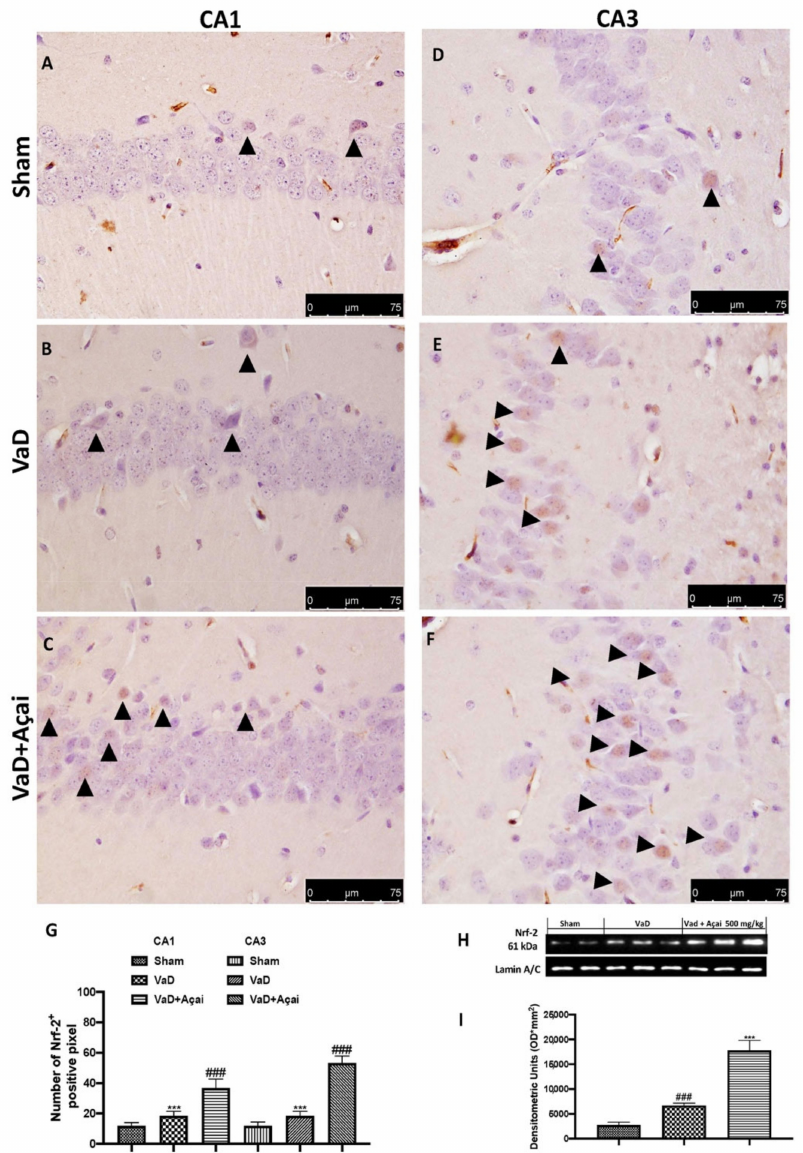
Figure 5. Açai berry improve NRF-2 expression. Hippocampal CA1 figure of Sham ( A ), VaD ( B ), Açai Berry ( C ); Hippocampal CA3 figure of Sham ( D ), VaD ( E ), Açai Berry ( F ); Number of Nrf-2 positive pixel ( G ); ( H ) western blot of NRF-2 expression and ( I ) relative densitometric analysis. Arrows indicate Nrf-2 positive cells. Figures are representative from at least three experiments. Values are means ± SEM of six mice for all groups. See manuscript for further details. *** p < 0.001 vs. sham; ### p < 0.001 vs.